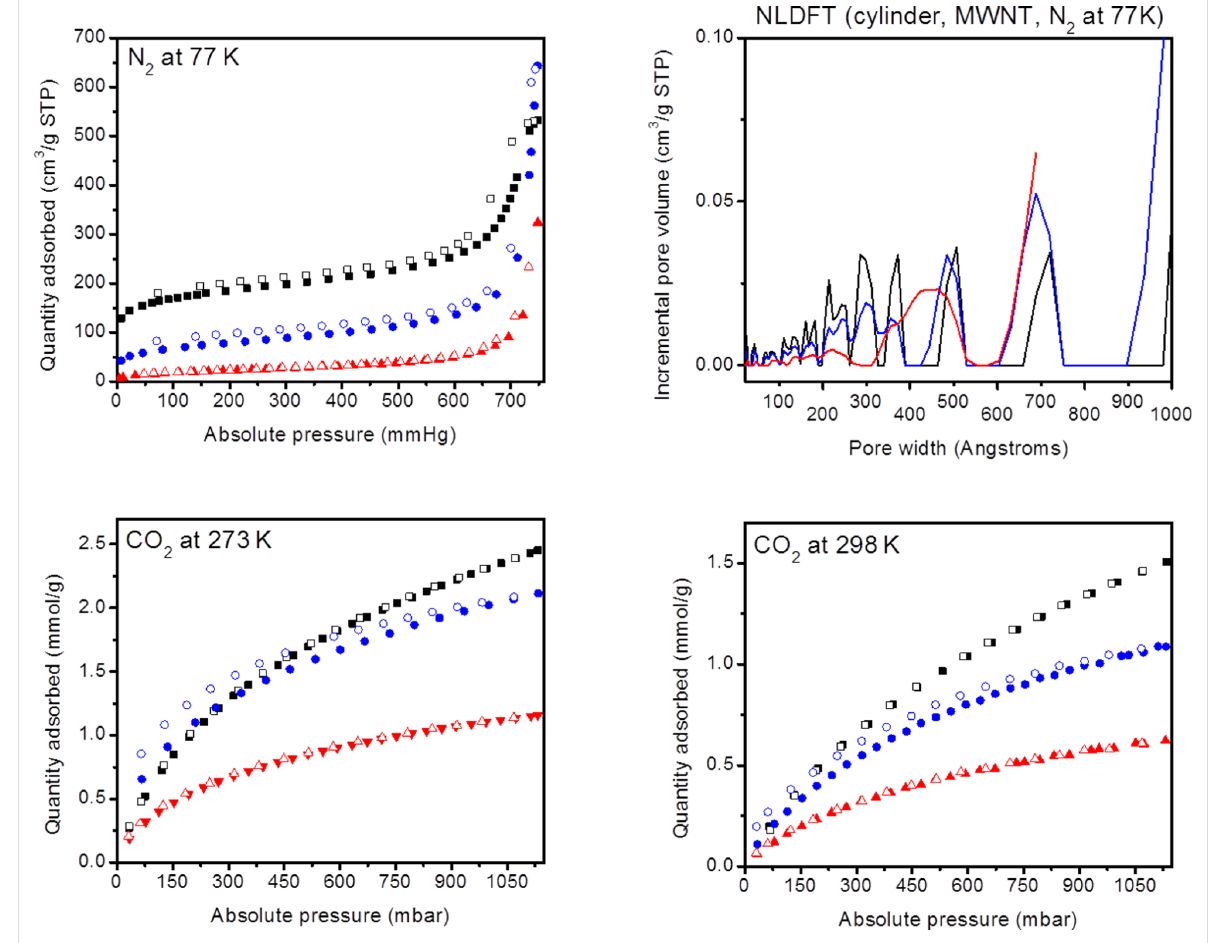
Figure 2: Gas adsorption (filled dots)-desorption (empty dots) isotherms and pore size distribution of COP-156 (black), COP-156-amine (blue) and COP-156-amidoxime (red).